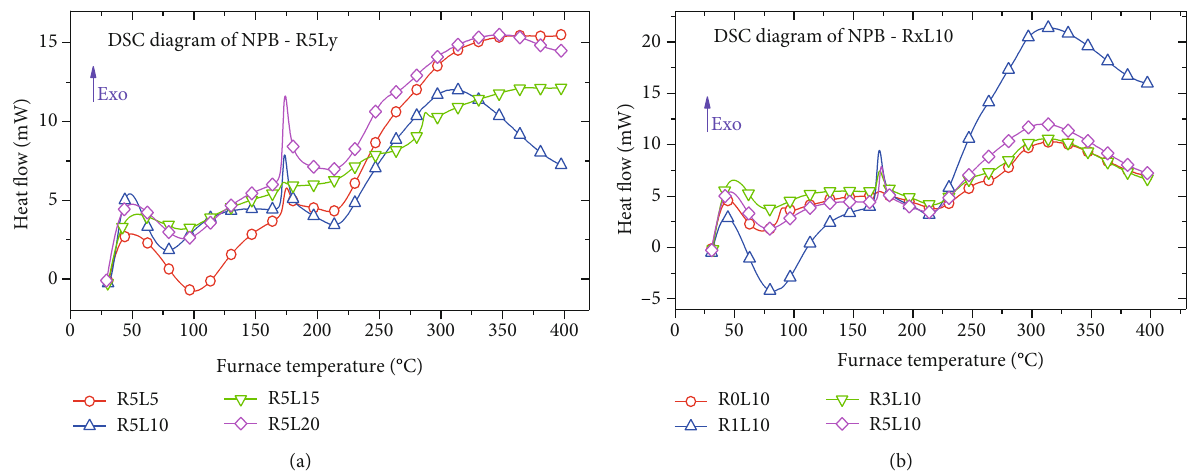
Figure 8: DSC diagrams of NPB with altered Lov content: R5Ly (a) and with altered ginsenoside Rb1 content RxL10 Table 4: Endothermic peak and exothermic peak temperatures of AG, CS, Lov, ginsenoside Rb1, and NPB using di ff erent content of Lov and ginsenoside Rb1.